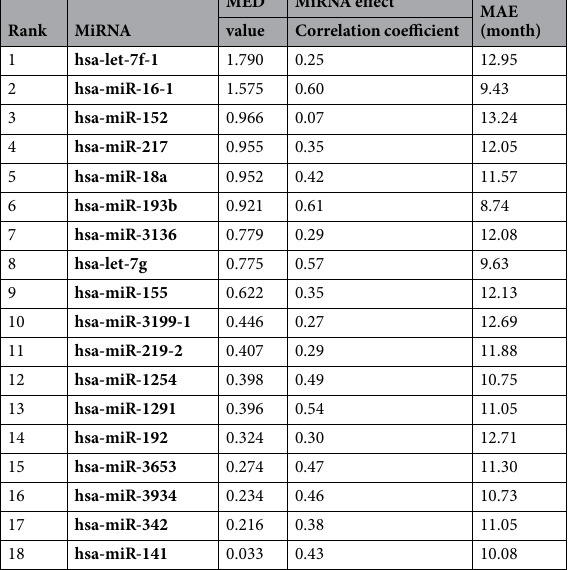
Table 2. Contribution of individual miRNAs using MED and individual miRNA